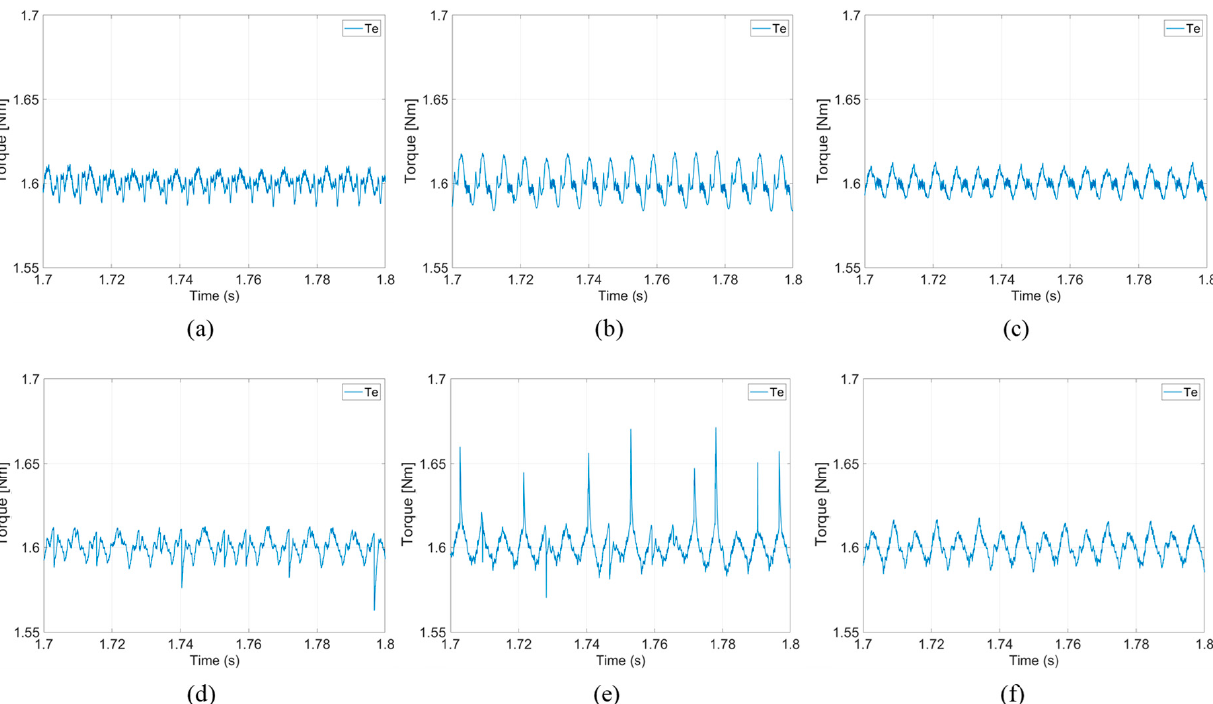
Figure 11. Simulation results of phase current harmonics in steady state at 400 rpm and 1.6 Nm.